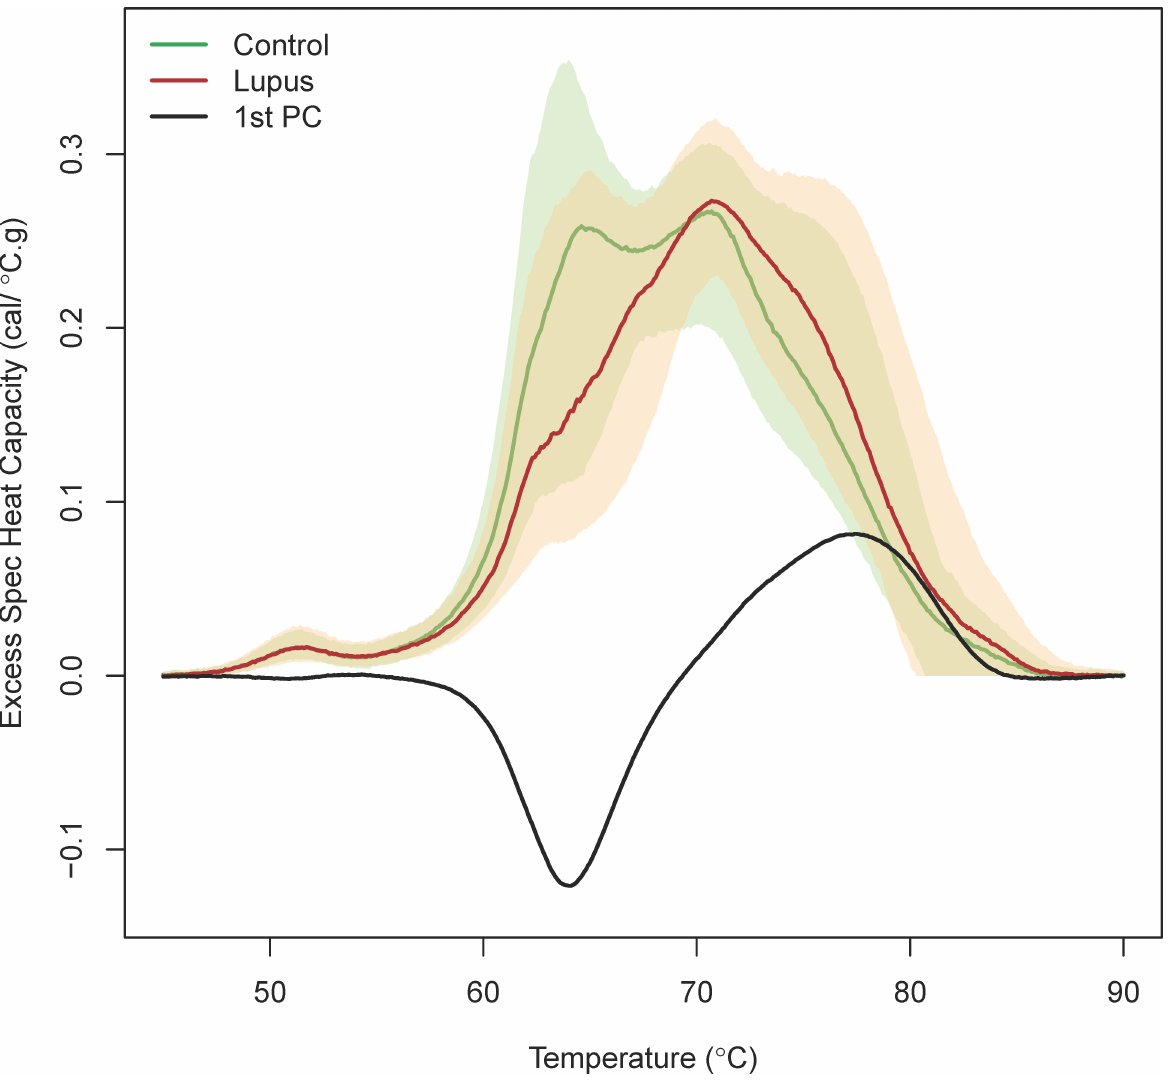
Fig 1. Plot of the median thermogram value at each temperature for lupus and control subjects. Bands represent the 5th and 95th percentilesamong subjects at each temperature. The loadingsfor the first principalcomponentamongall subjects are shown as the black